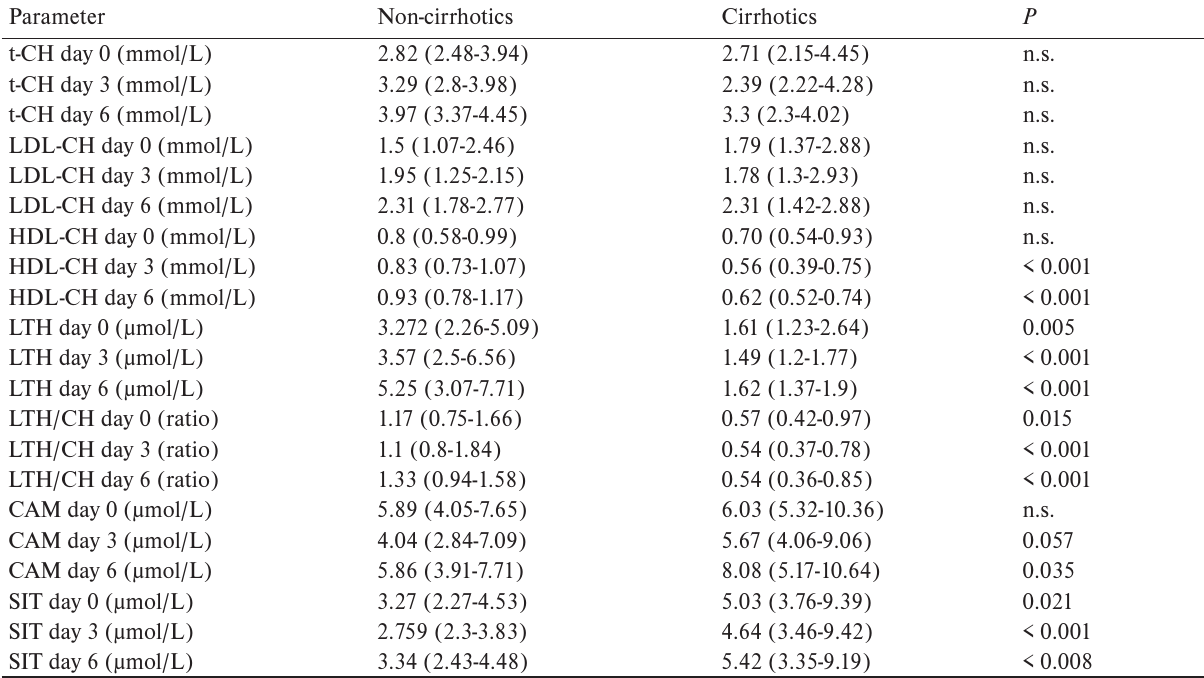
t-CH: total cholesterol, LDL-CH: low density cholesterol, HDL-CH: high density cholesterol LTH: lathosterol, LTH/CH: lathosterol to cholesterol ratio, CAM: campesterol, SIT: